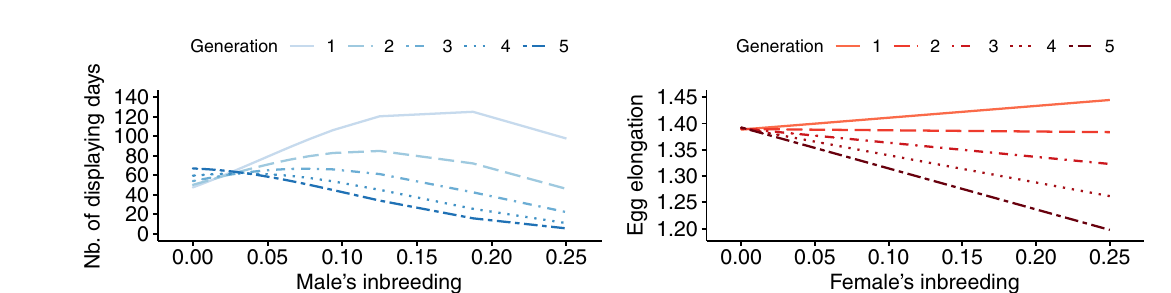
Figure 6. Predicted values of the number of displaying days and egg elongation according to the interaction between inbreeding and number of generations in captivity. The interaction between inbreeding and generation zero was not performed since founders (i.e., individuals of generation zero) were assumed to be neither inbred nor